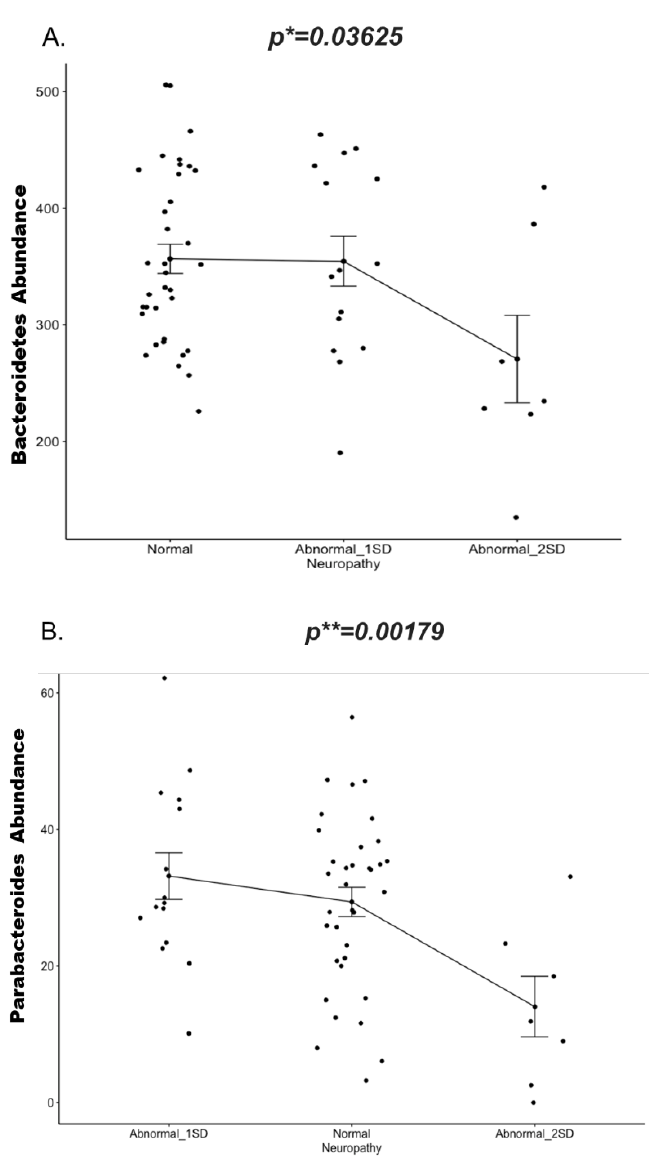
Figure 6. Change in abundance ( y -axis) of ( A. ) Phylum Bacteroidetes and ( B. ) Genus Parabacteroidetes in the neuropathy group( x -axis) at two standard deviations (1SD and 2SD lower than the mean of controls) compared to normal subjects (without neuropathy). Significance is determined by the linear mixed model. Corrected p values are indicated on the graph. * p ≤ 0.05; ** p ≤ 0.01). Abbreviations: SD = Standard deviation.